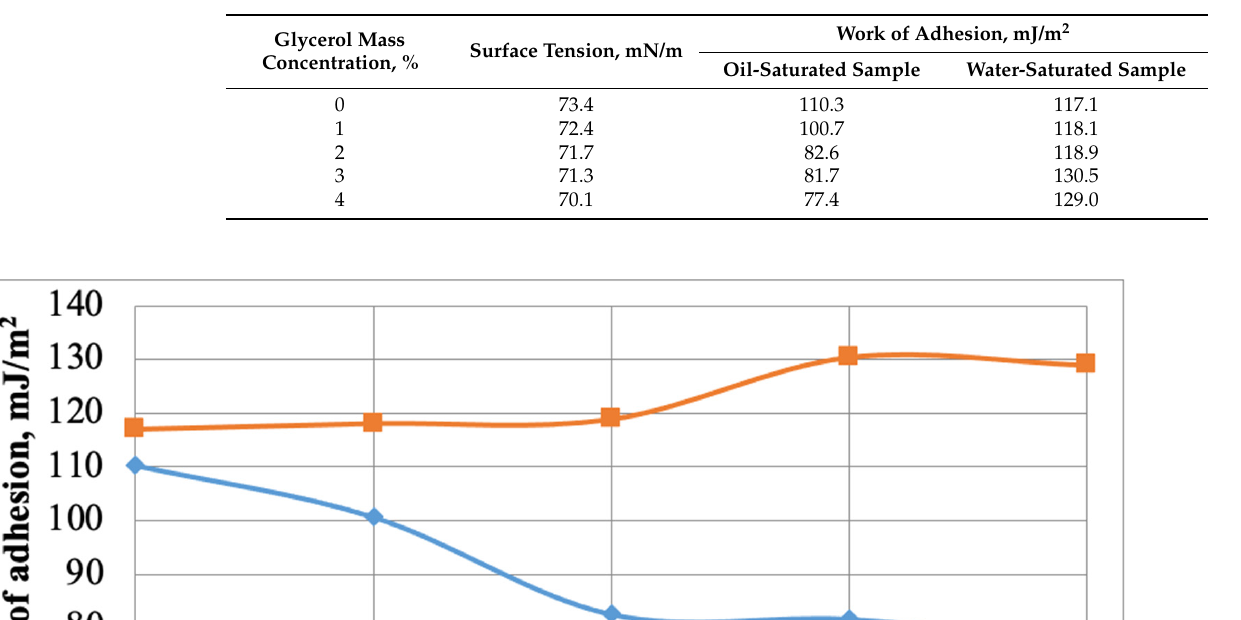
Table 2. Correlation between the work of adhesion and the glycerol concentration in “Silicate” shutoff composition.